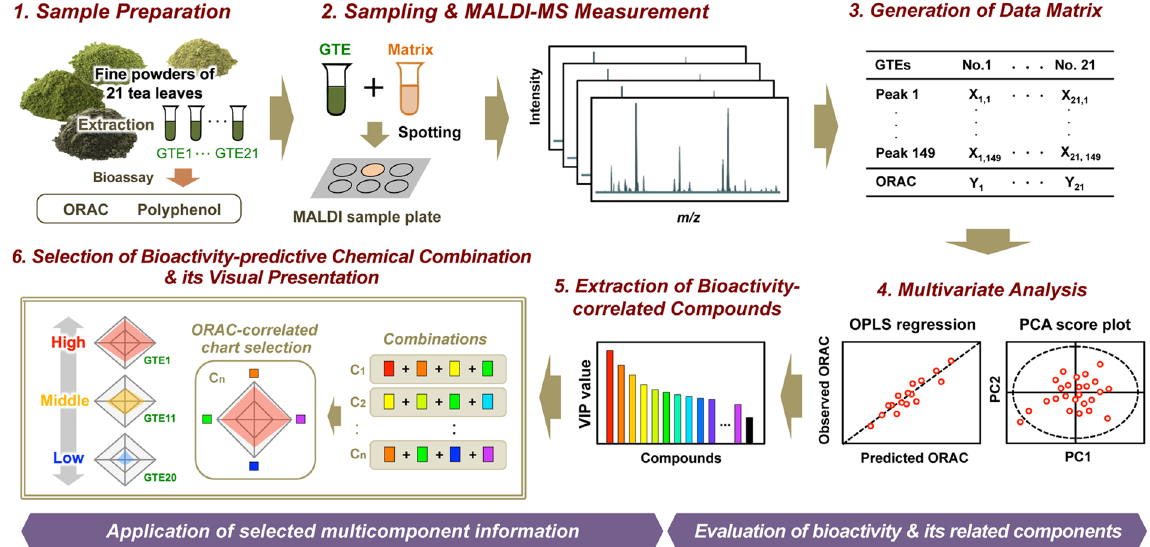
Figure 1. Experimental design for chemometrics-based evaluation of bioactivity of 21 GTE panels representing multicomponent